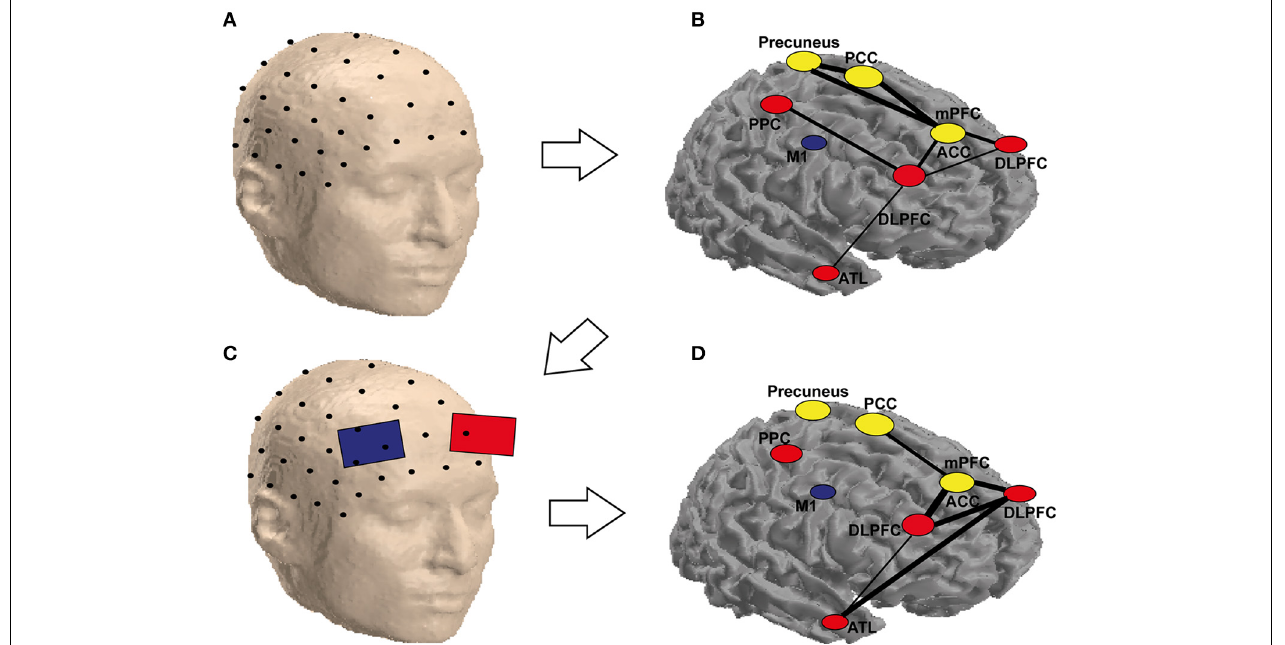
FIGURE 2 | Schematic representation of the possible combination of tCS and functional (EEG) brain connectivity to enhance creativity. An array of scalp electrodes, a subset of which is depicted in (A) , is recorded. In (B) is possible to identify ROIs which are highly connected (yellow) and the ones that are flexible hubs (red) or less connected areas (blue) during a solution vs. non-solution RAT task. This helps identifying the target electrodes to stimulate as in (C) . Stimulating these electrodes may not only eliminate the differences for the corresponding nodes, but also reduce them for areas in the same network, which are not stimulated but